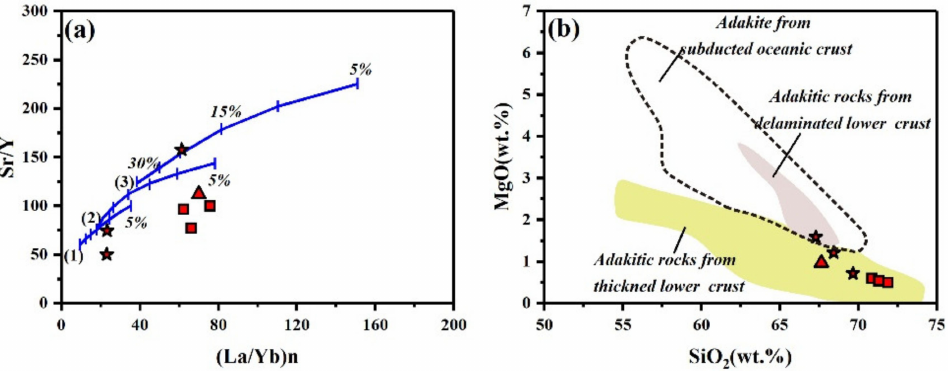
Figure 6. ( a ) Sr/Y vs. (La/Yb) n [21], ( b ) SiO 2 vs. MgO [49]. Curves 1, 2, and 3 in Figure 6a show batch partial melting with residual phases of 30% garnet + 69% clinopyroxene + 1% rutile (1), 15% garnet + 84.5% clinopyroxene + 0.5% rutile, (2), and 5% garnet + 94.9% clinopyroxene + 0.1% rutile (3). Segments on curves indicate 5% increments in the melt